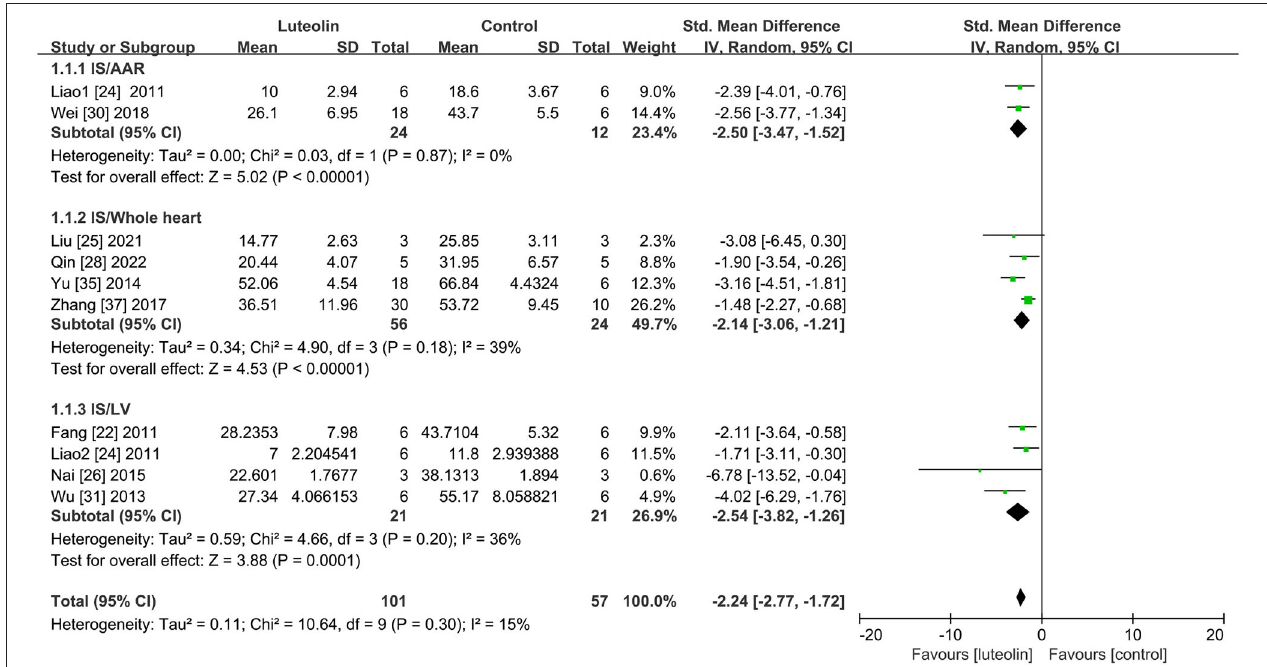
FIGURE 2 | Forest plot showing changes in myocardial infarct size. IS, infarct size; AAR, area at risk; LV, left ventricular.